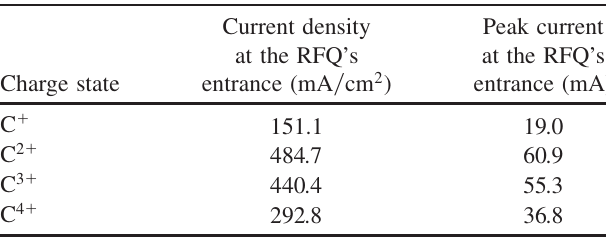
TABLE XI. Peak current and current density of each